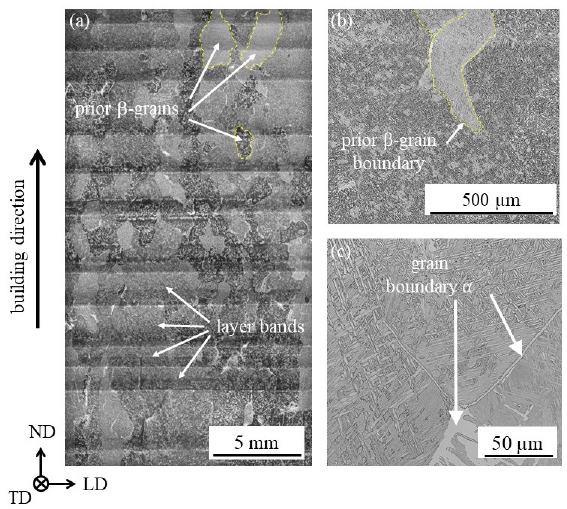
Figure 3. WAAM-fabricated Ti-6Al-4V; ( a ) layered structure of WAAM-fabricated Ti-6Al-4V, ( b ) domains represent prior β -grains, ( c ) domains contain short-lamellar grains.